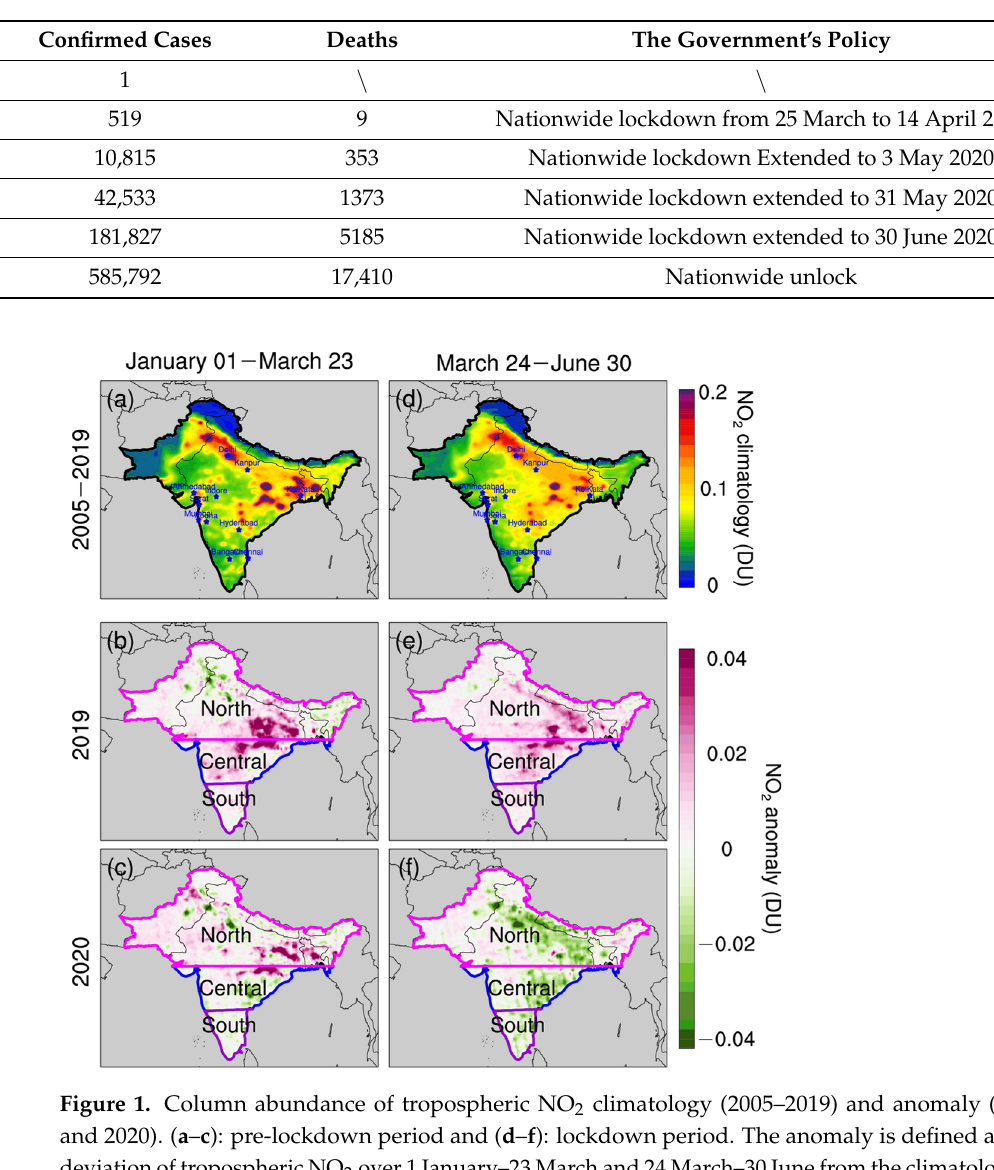
respectively. DU is the Dobson unit, which is equivalent to ~0.45 mmol m − 2 . Data are retrieved from the Ozone Monitoring Instrument (OMI). The asterisks in ( a , d ) represent major cities in the Indian subcontinent.